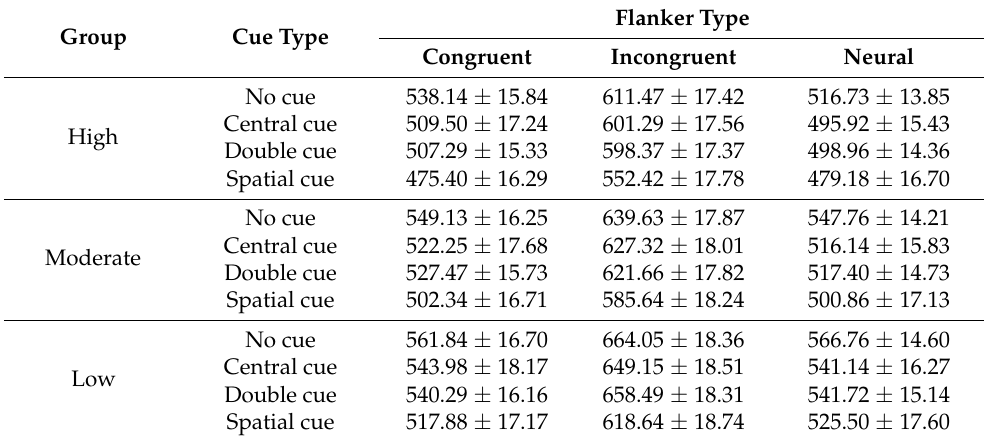
Table 2. Mean reaction times on trials with correct responses in the Attention Network Test for groups with high, moderate, and low physical activity (mean ± standard